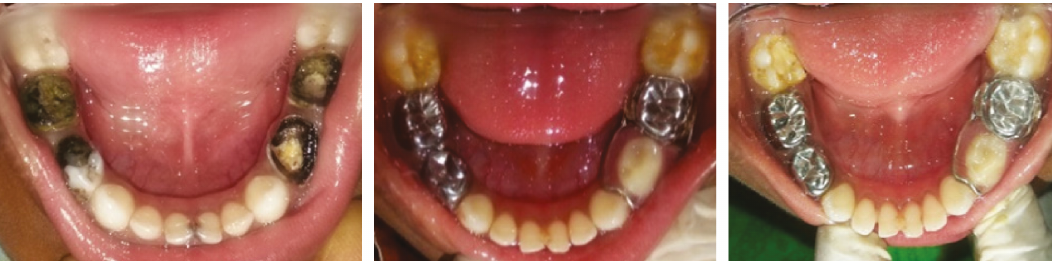
Figure 3: Preoperative, immediate postoperative, and one-year postoperative occlusal views of the mandibular arch with the functional band and loop space maintainer in the tooth 74 region.